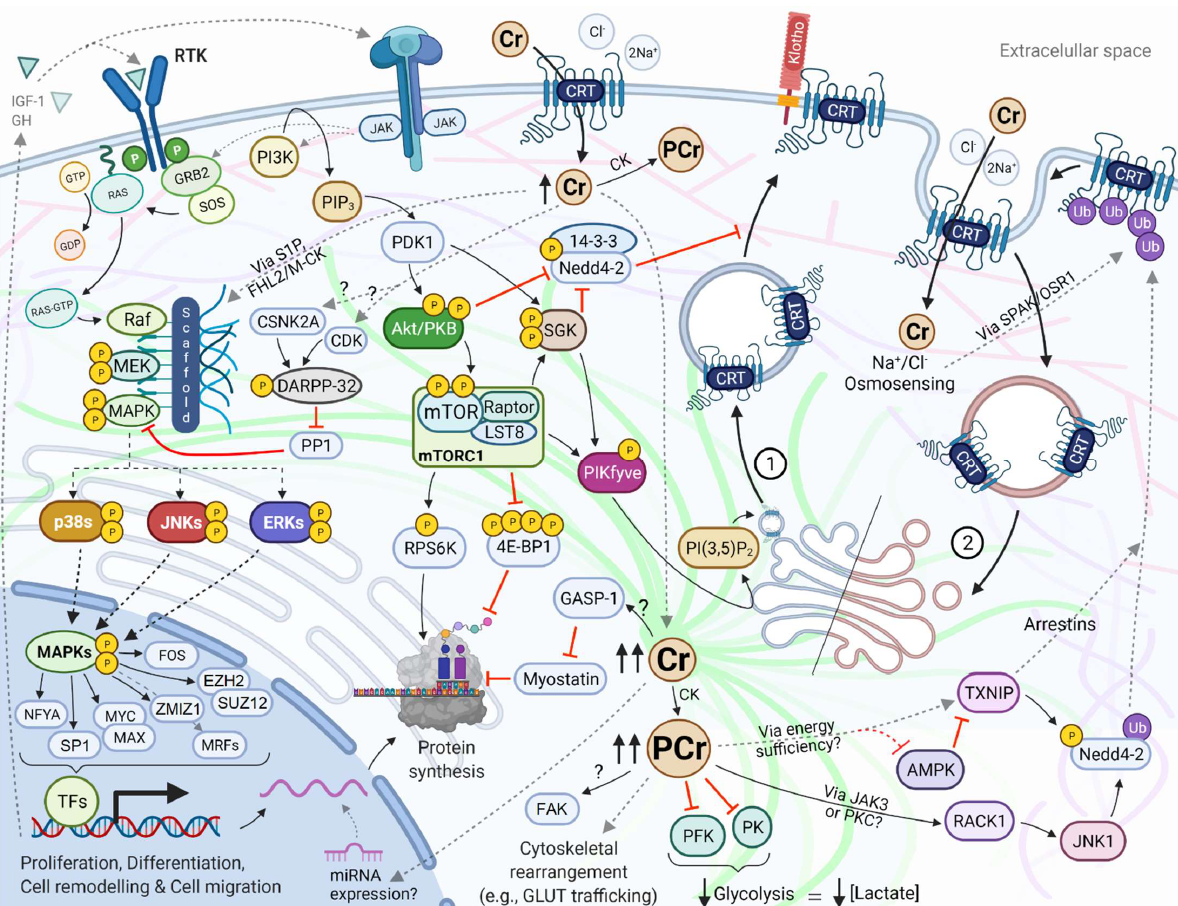
Figure 4. Bioinformatics- and knowledge-based pathway reconstruction after Cr supplementation. This is a representation of pathways interactions based on the results of our enrichment analysis of differentially expressed genes after increasing cellular Cr concentration and the available experimental evidence. This functional network follows the ‘bio-logic’ (integration of bottom-up and top-down directions) of the genotype–outcome interaction. MAPK activation can occur via osmosensing pathways that activate Ras/Raf (e.g., S1P/SPHK1) and mechanosensing pathways that involve mechanical and energy optimization of the cytoskeleton (e.g., Four-and-a-Half Lim 2 is an important mechanosensor that triggers hypertrophy in response to strain and also docks key metabolic enzymes involved in the energy transduction process, such as M-CK, adenylate kinase, and phosphofructokinase). Several subunits of the protein complexes and the architecture